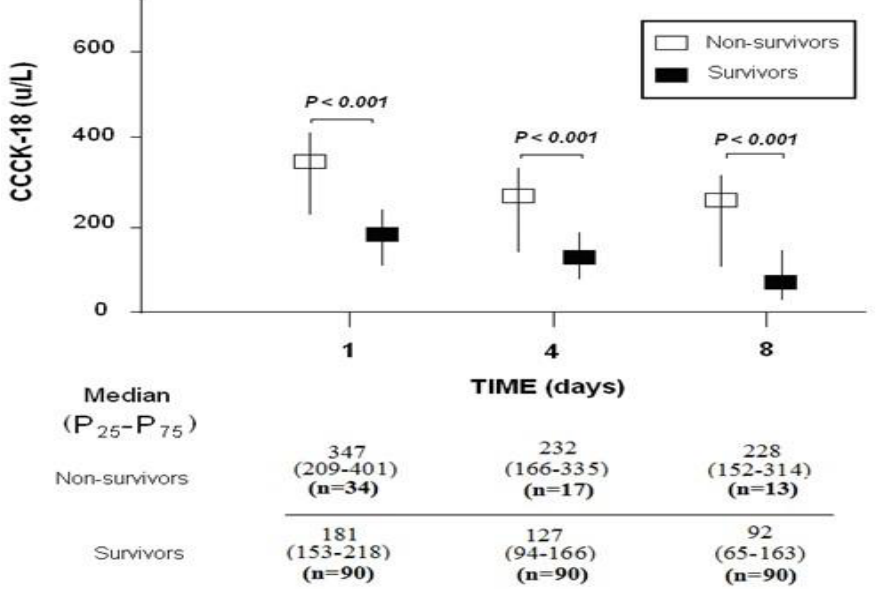
Figure 1. Serum levels of caspase-cleaved cytokeratin (CCCK)-18 on day 1, day 4, and day 8 after trauma brain injury in survivor and non-survivor patients. Table 2. Receiver operation characteristic analysis using serum caspase-cleaved cytokeratin (CCCK)-18 levels on day 1, day 4, and day 8 after trauma brain injury as predictor of mortality at 30 days.